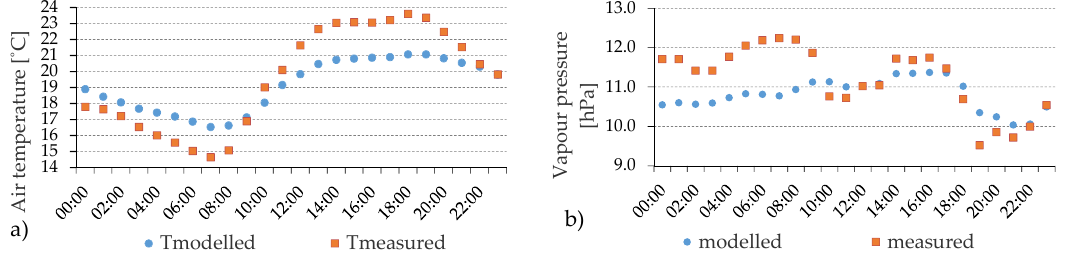
Figure 2. Hourly evolution of measured and modelled T a ( a ) and e ( b ) on the 19th June 2011.